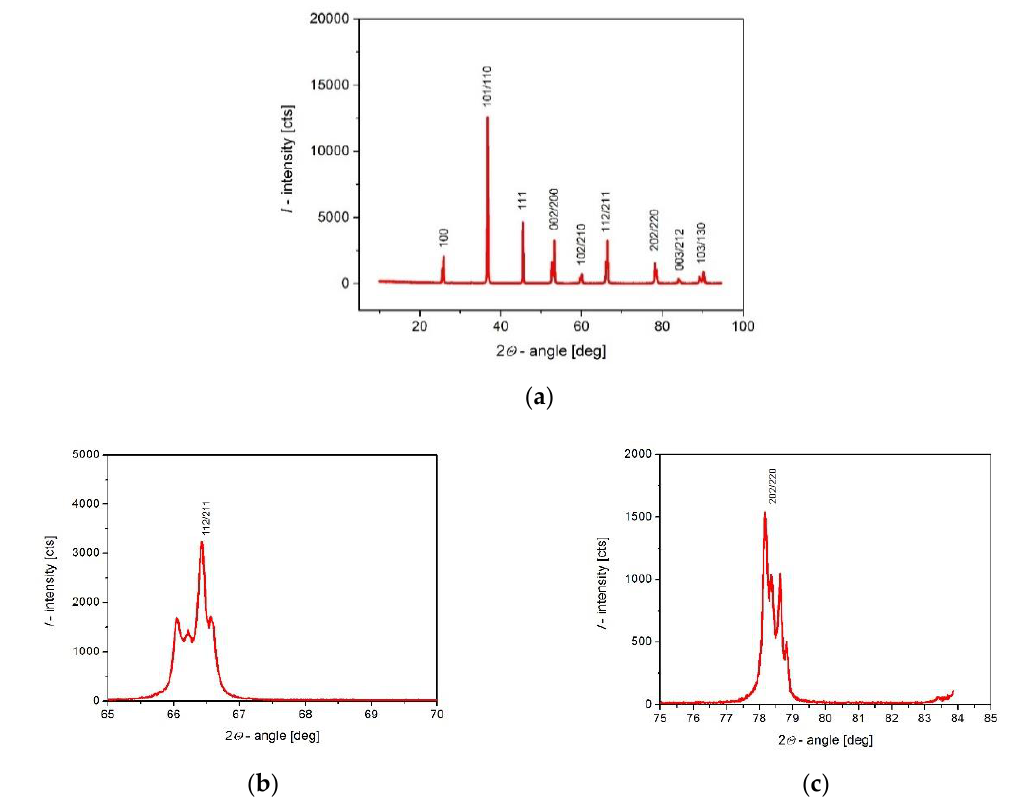
Figure 1. ( a ) X-ray diffraction pattern of BLT4 ceramics. ( b ) magnification of 112/221 peak; ( c ) magnification of 202/220 peak.